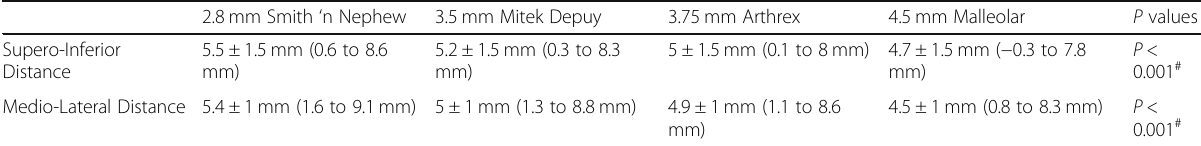
Table 3 Distance from Coracoid Borders According to Implant